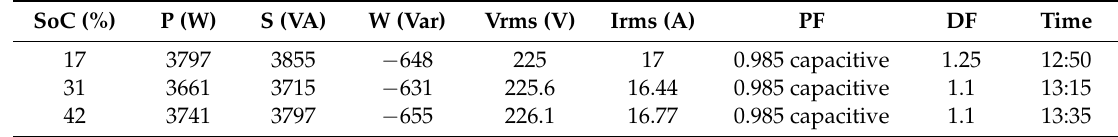
Table 10. Measured data from a 24-kWh electric vehicle while